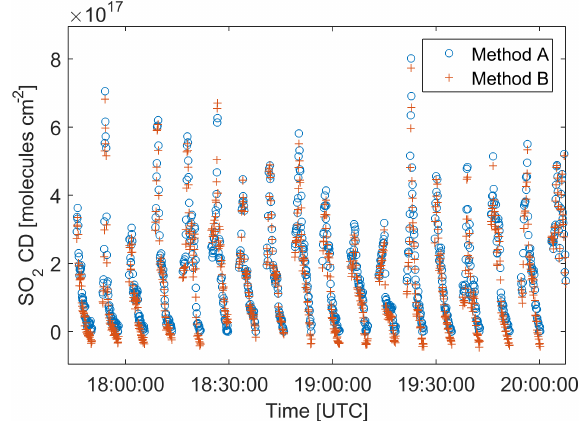
Figure 8. Zoom into the variation of the SO 2 CD at Nevado del Ruiz from instrument D2J2201 on 11 January 2012. In this example both methods agree well.